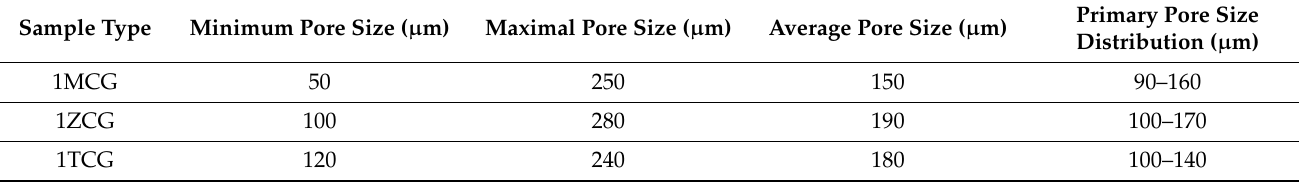
Table 3. Pore diameter of CS/gel/mineral porous gel.